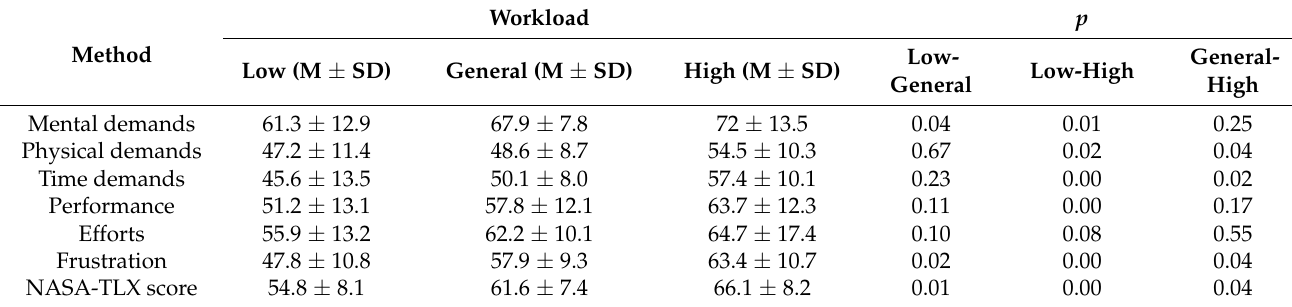
Table 4. The t -test of NASA-TLX between different workloads.